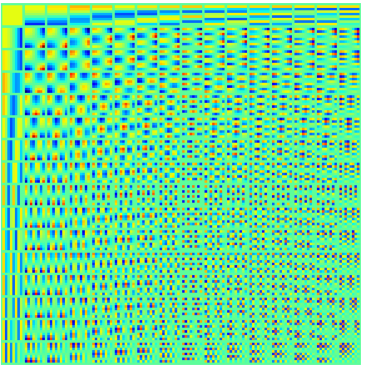
Figure 1. DCT over-complete